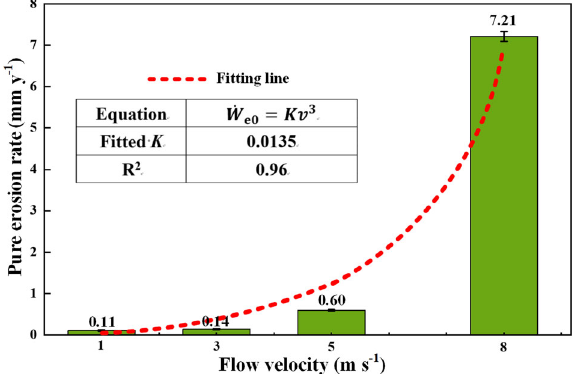
Fig. 5 The general pure erosion rate of EH 32 steel at different fl ow velocities. The general pure rate is fi tted from the pure erosion equation and the fi tting results are presented as the dashed line in the fi gure. The error bars represent standard deviations of the three repeated tests at each fl ow